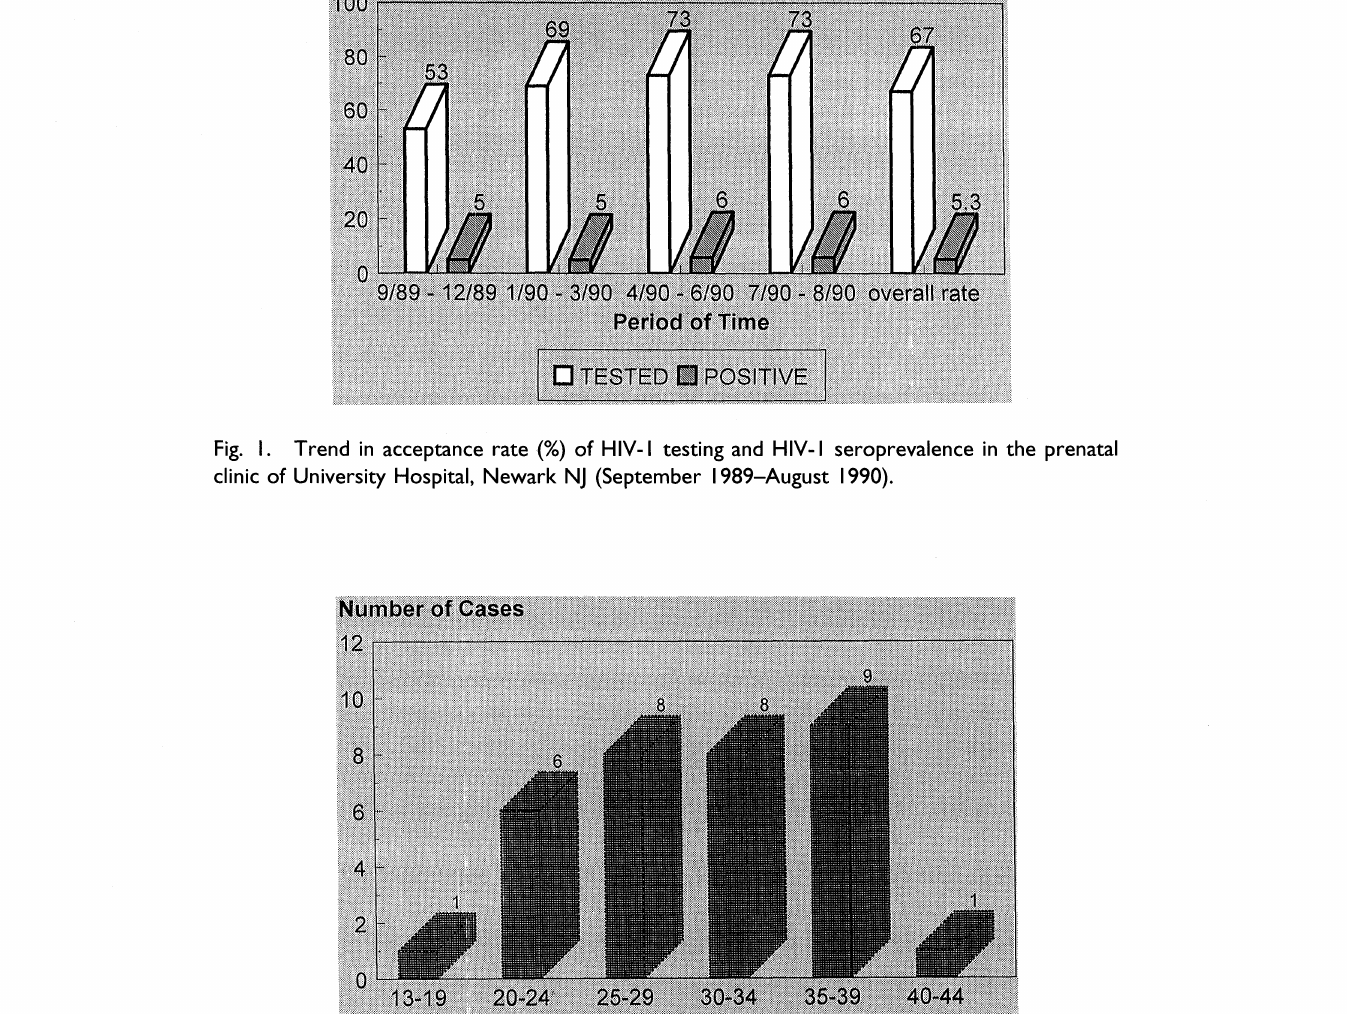
Fig. I. Trend in acceptance rate (%) of HIV-I testing and HIV-I seroprevalence in the prenatal clinic of University Hospital, Newark NJ (September 1989-August 1990).